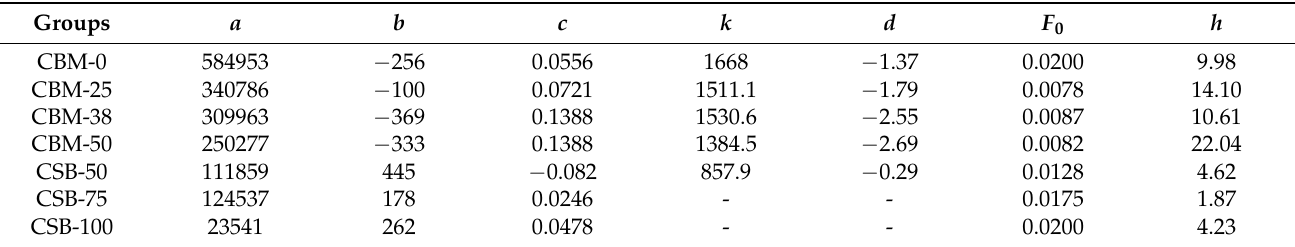
Table 8. Related parameters of constitutive